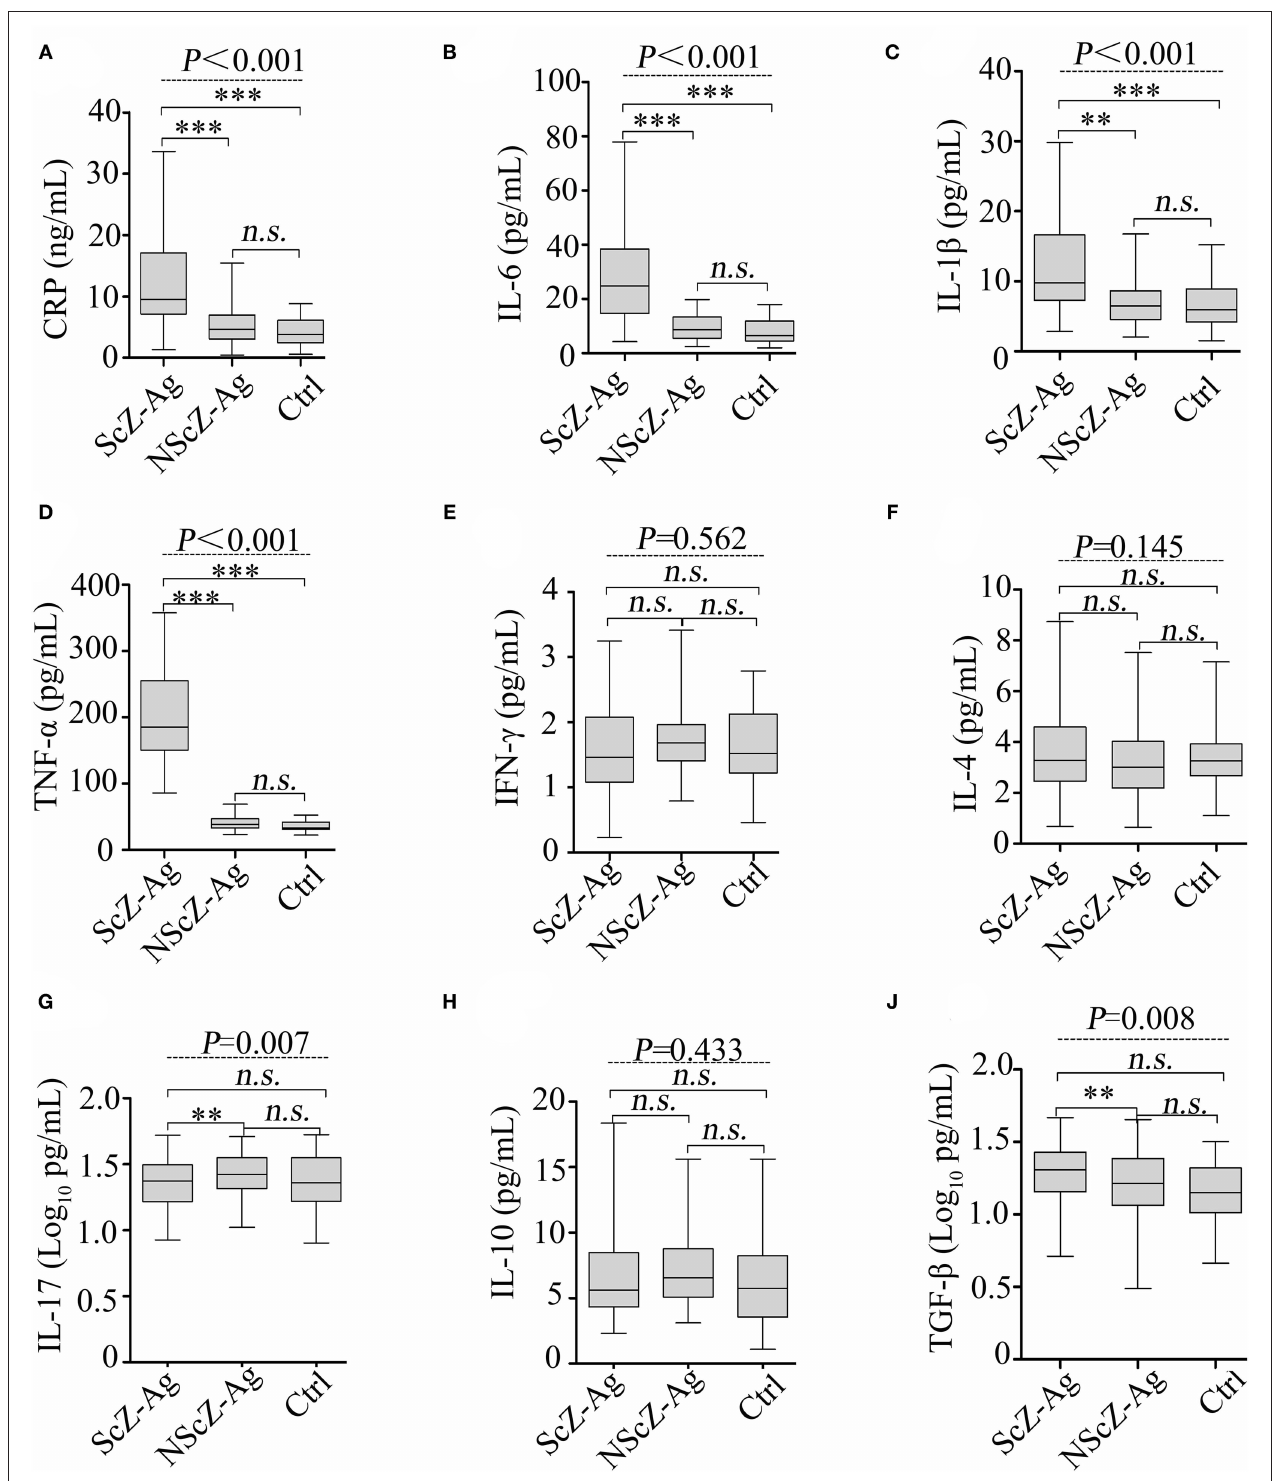
FIGURE 1 | Protein levels of serum CRP (A) , IL-6 (B) , IL-1 β (C) , TNF- α (D) , IFN- γ (E) , IL-4 (F) , IL-17 (G) , IL-10 (H) and TGF- β (J) in peripheral blood of subjects. CRP, C-reactive protein; IL, interleukin; TNF, tumor necrosis factor; TGF, transforming growth factor. Data were presented as boxplots. In post-hoc analysis using Bonferroni’s multiple comparison test, n.s . > 0.05, * P < 0.05, ** P < 0.01, *** P < 0.001 analysis using ANCOVA.